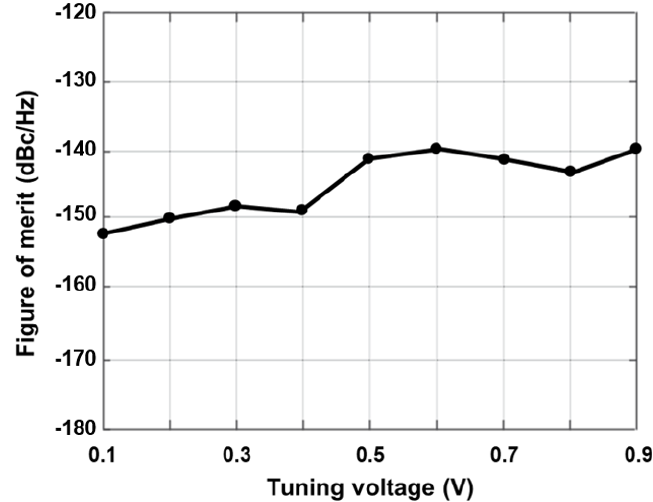
Figure 11. Figure of merit of the designed VCO.